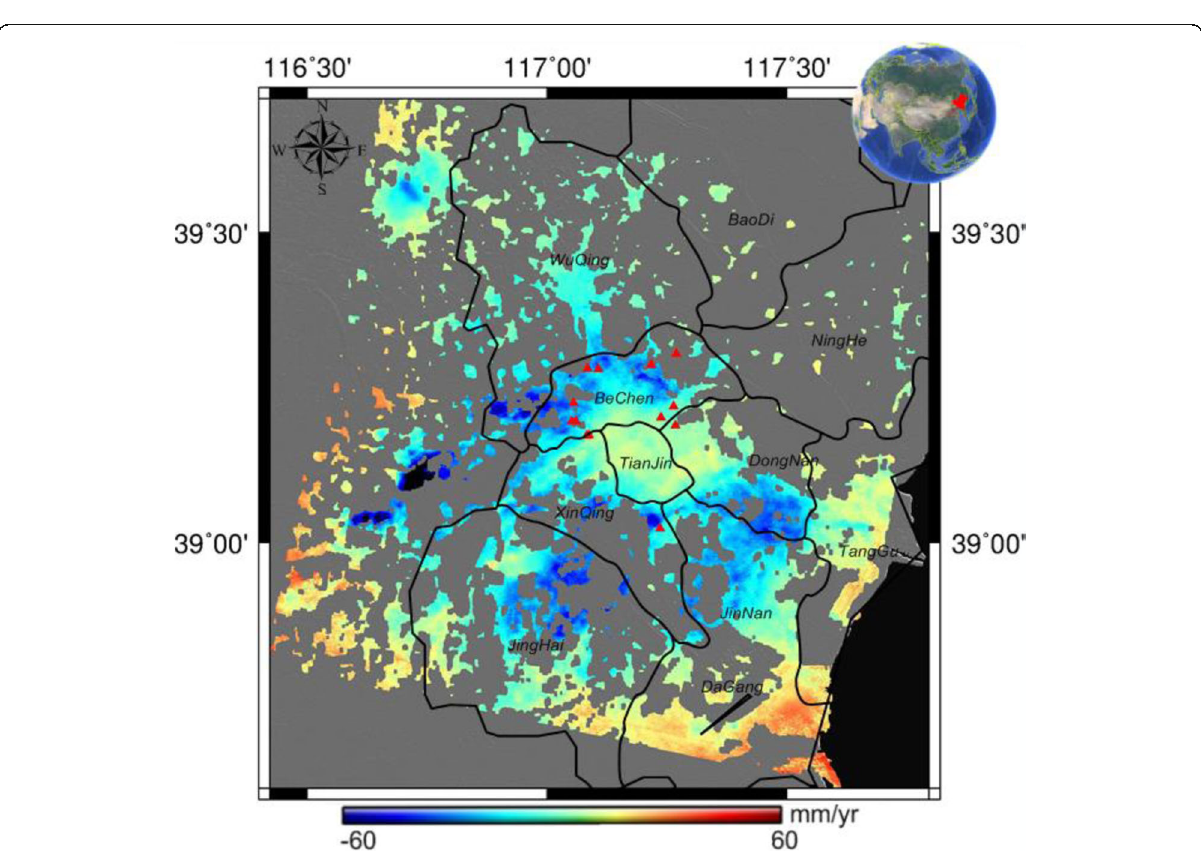
Fig. 5 Subsidence rate of the Tianjin